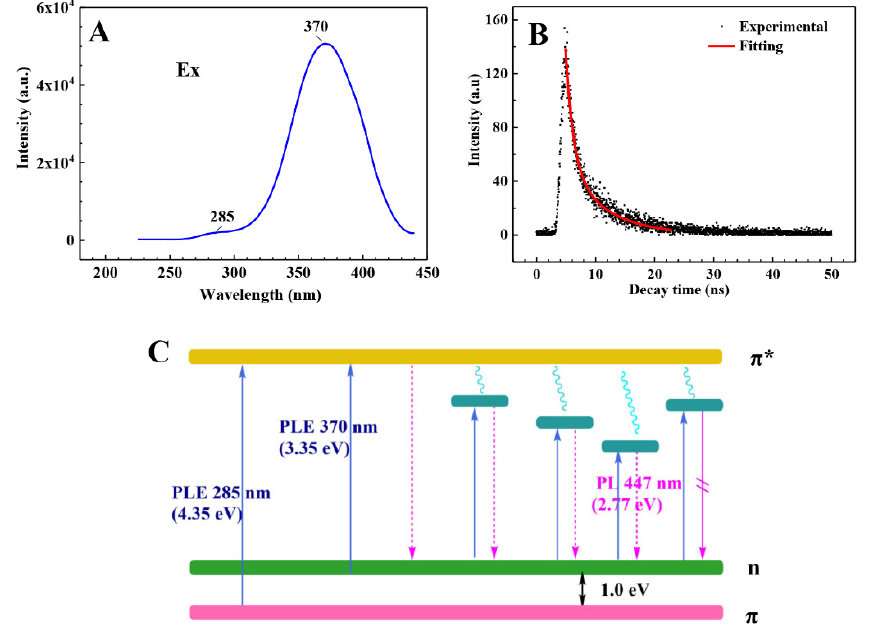
Figure 6. The photoluminescence mechanism of the N-GQDs: ( A ) the excitation spectrum obtained under the monitor emission wavelength at 447 nm and the excitation in the range of 200–430 nm; ( B ) the fluorescence lifetime of the N-GQDs; and ( C ) the schematic energy level of the N-GQDs.